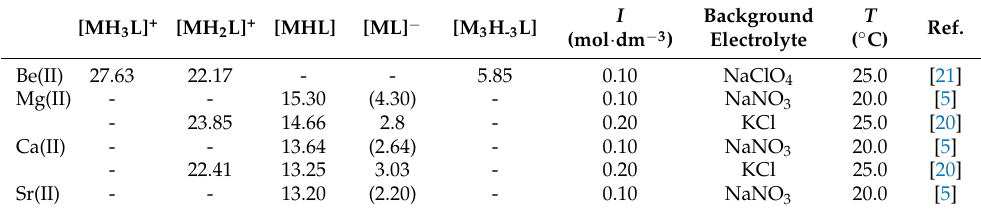
Table 3. Overall complex-formation constants (log β ) of DFOB with alkaline earth metal ions under different experimental conditions. The constants in parentheses correspond to the formation of the 1:1 complex of M(II) with DFOB protonated at its amino group and therefore refer to the equilibrium: M 2+ + HL 2 − =